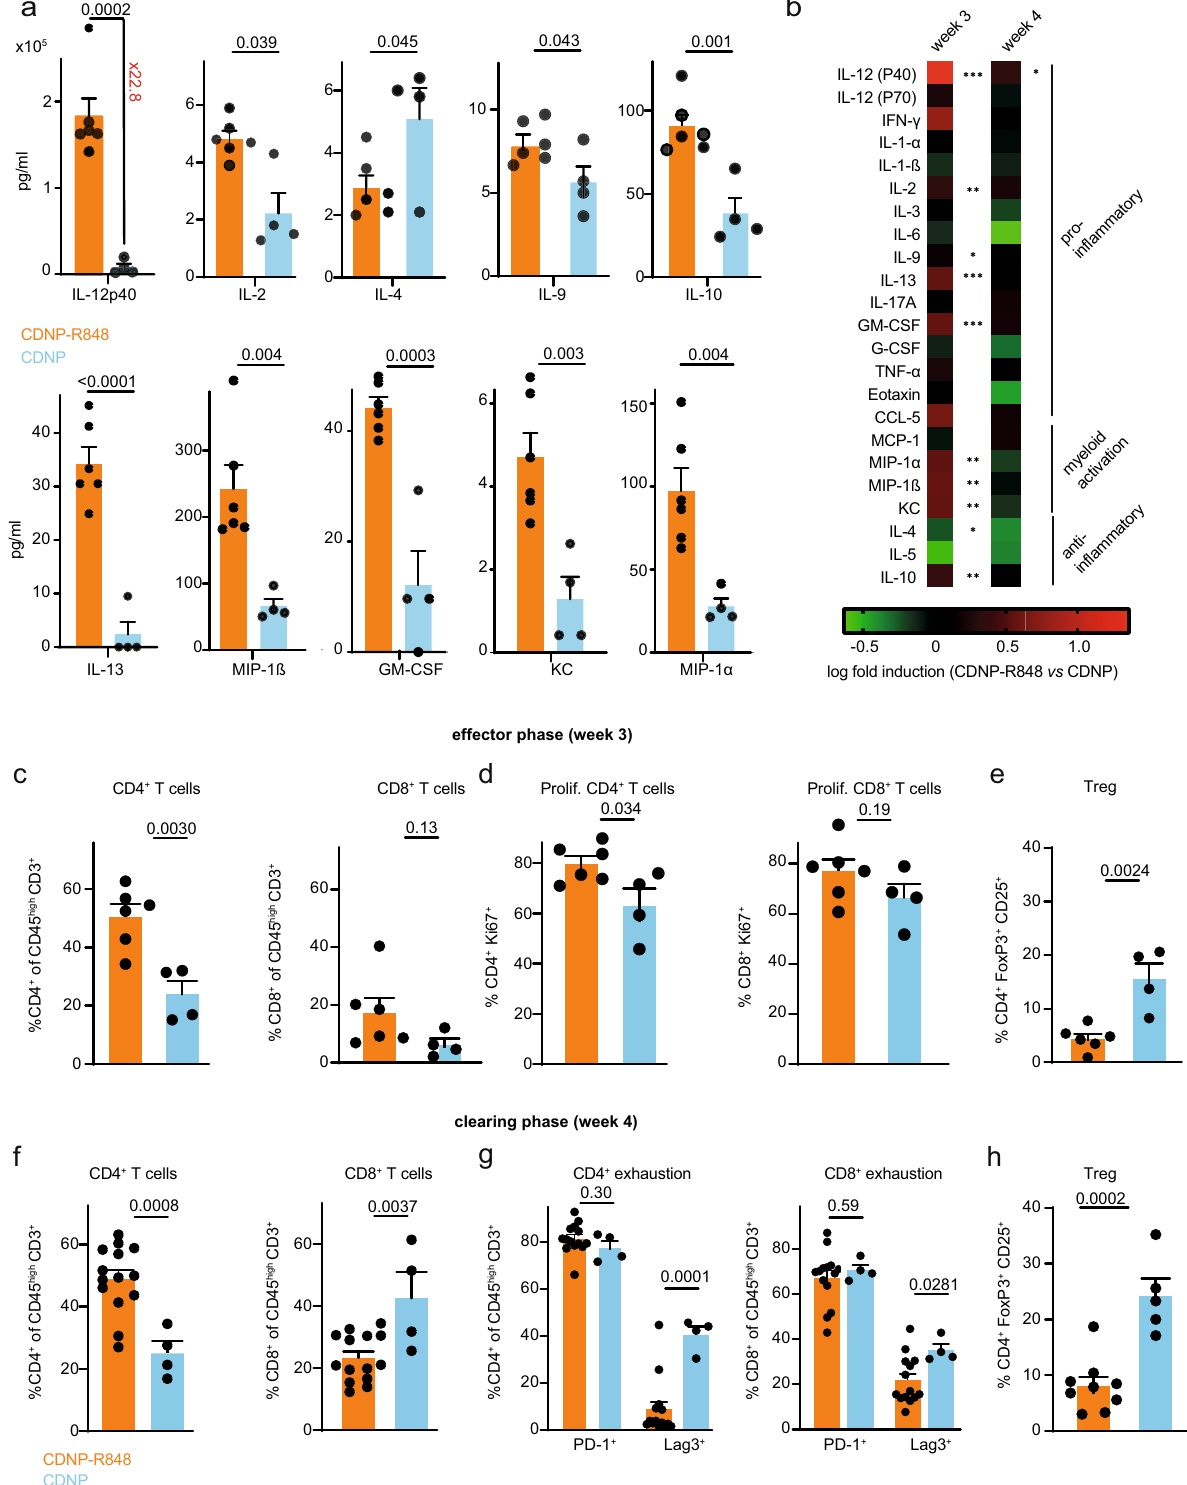
Fig. 3 | CDNP-R848 shapes the tumor microenvironment. a Luminex cytokine pro fi ling at d21 (CDNP-R848: n =6 micevsCDNP: n =4mice, pooled data from two independent experiments). After enzymatic digestion of the tumor-bearing hemi- sphere, supernatant was taken and Luminex cytokine pro fi ling was performed for indicated cytokines. b Heatmap showing Luminex cytokine results for effector (week 3) and clearing phase (week 4). c – h Flow cytometric analysis of tumor-